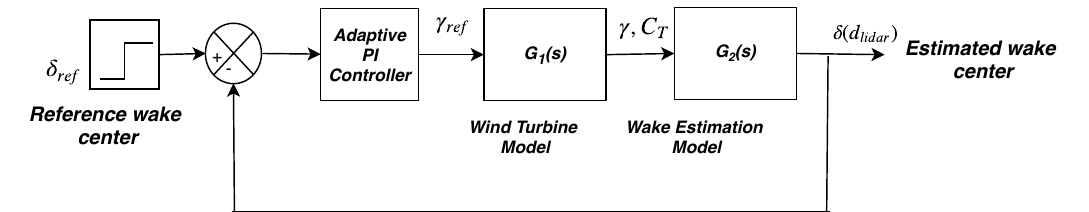
Figure 1. Wake center estimation for a single set of upwind and downwind